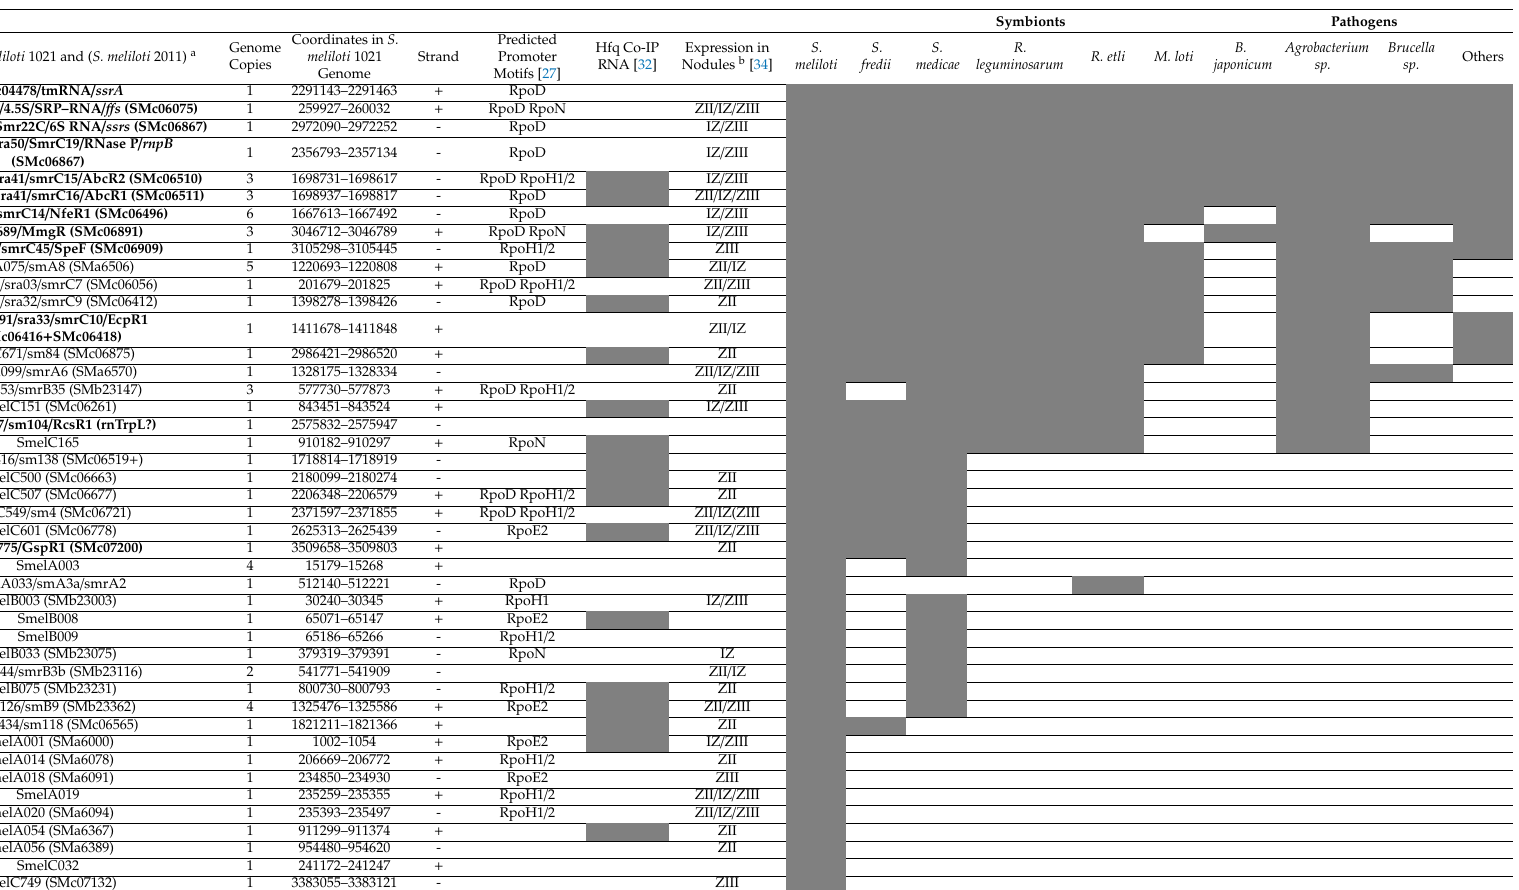
Table 1. Identification, conservation and functional data of S. meliloti